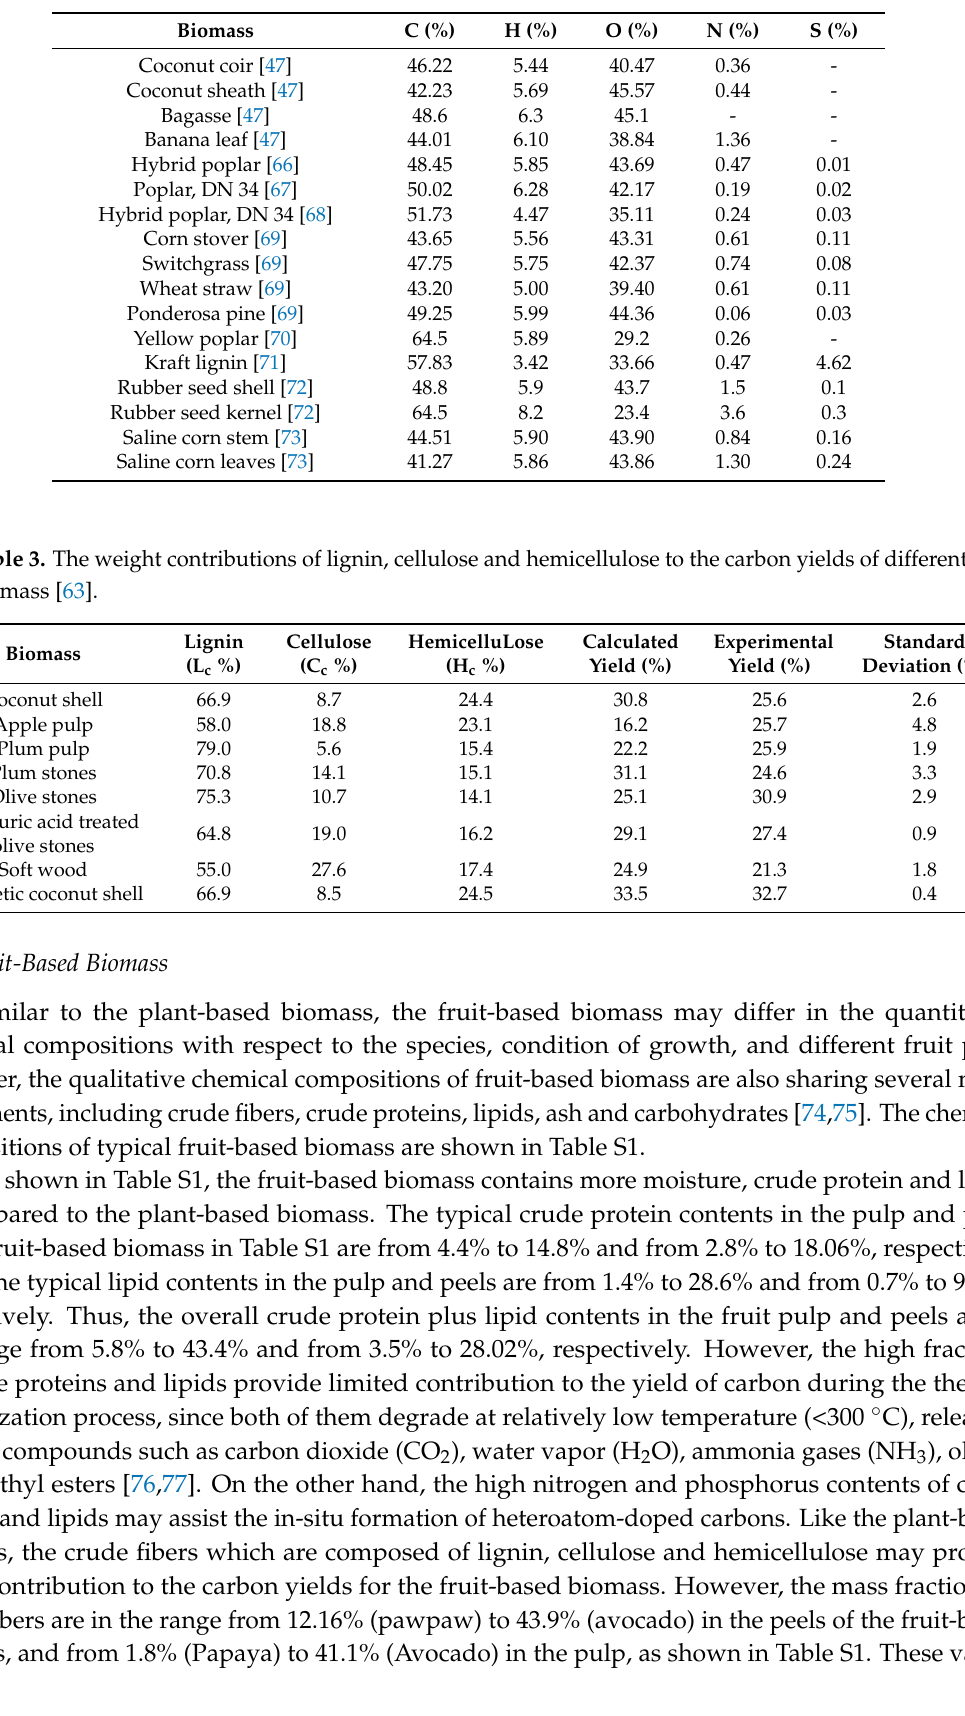
Table 2. Elemental compositions of different plant-based biomass (in dry weight % basis).